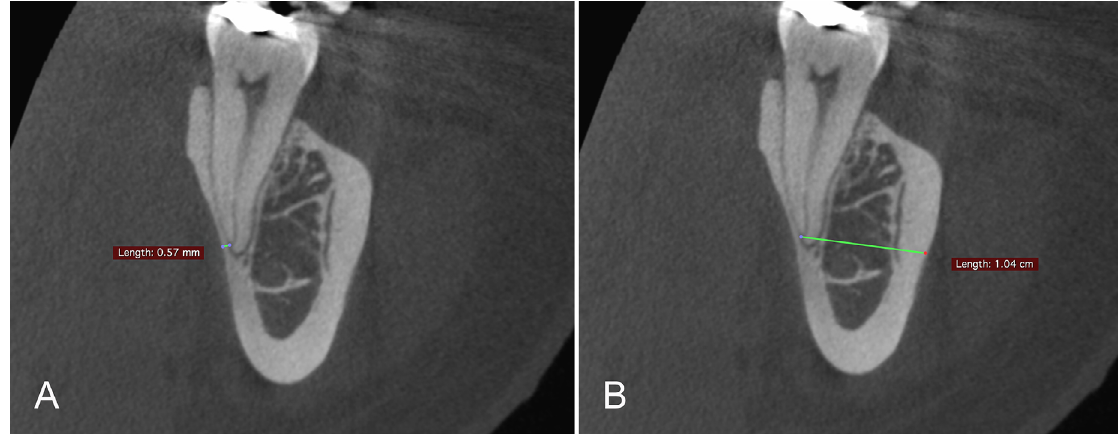
Figure 3- The smallest measurement for the posterior teeth was found in the coronal plane (buccal and lingual bone measurements)